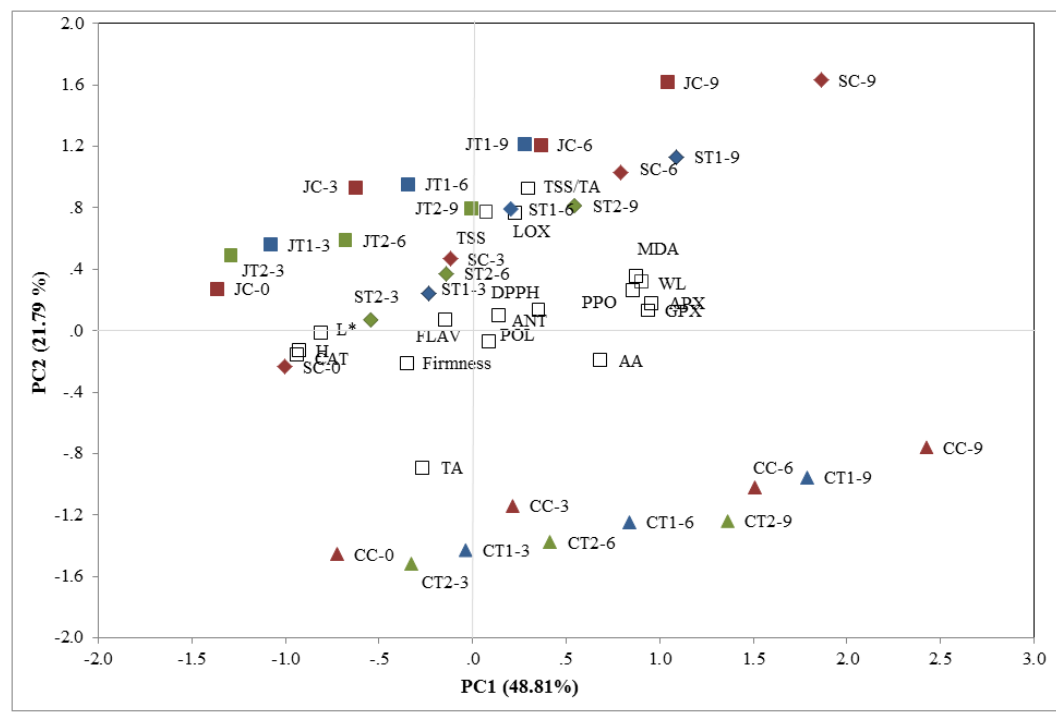
Figure 8. 2D-principal component analysis plot of the pomological, nutraceutical and enzymatic attributes in the three strawberry cultivars “Sabrina” (S), “Candonga” (C) and “Jonica” (J) at harvest (C0), 3 (C-3: uncoated fruit; T1-3 chitosan-coated (1%) fruit; T2-3 chitosan-coated (2%) fruit), 6 (C-6: uncoated fruit; T1-6 chitosan-coated (1%) fruit; T2-6 chitosan-coated (2%) fruit) and 9 (C9: uncoated fruit; T1-9 chitosan-coated (1%) fruit; T2-9 chitosan-coated (2%) fruit) days of cold storage (WL: weight loss; TSS: total soluble solid content; TA: total titratable acidity; TSS/TA: TSS/TA ratio; L: L* value; H: hue angle; POL: polyphenol content; FLAV: flavonoid content; AA: acid ascorbic content; DPPH: radical scavenging activity; CAT: catalase; APX: ascorbate peroxidase; GPX: guaiacol peroxidase; LOX: lipoxygenase; PPO: polyphenol oxidase; MDA: malondialdehyde